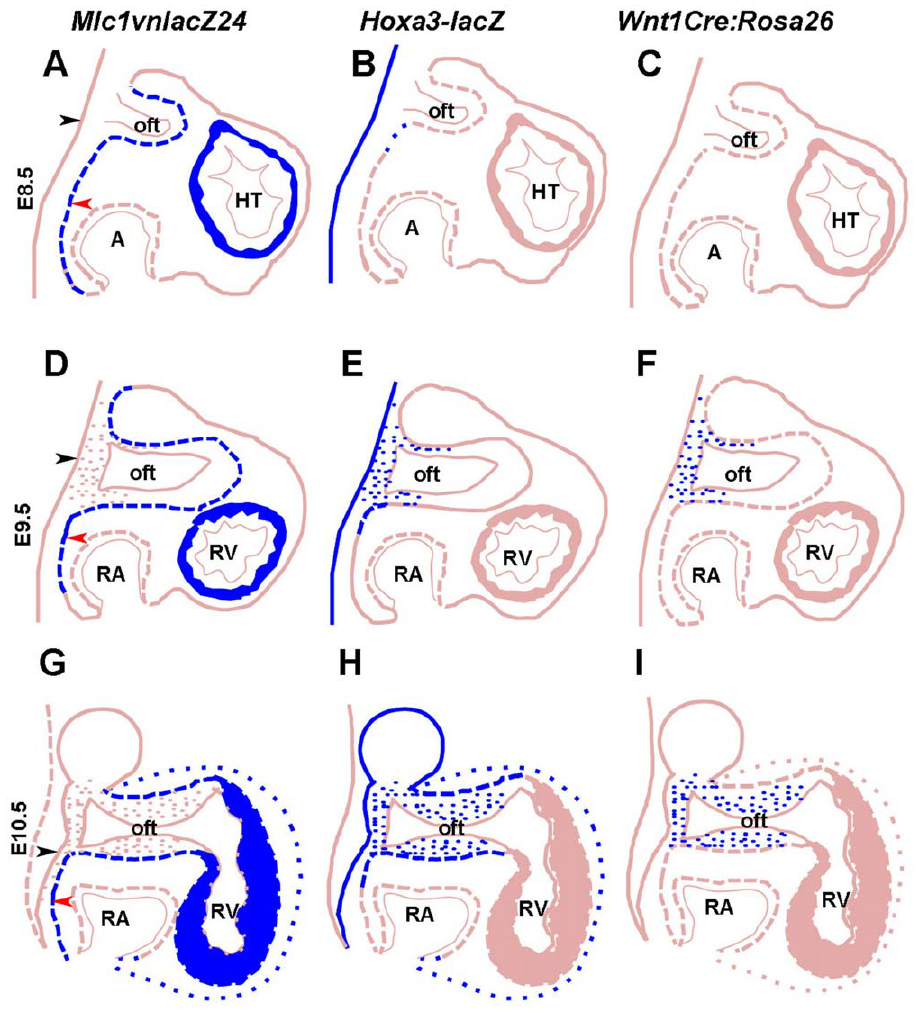
Figure 7. Schematic view of lacZ expression pattern in of Mlc1v-nlacZ24,Hoxa3-lacZ and Wnt1Cre:R26R cardiosensor lines. Mlc1v- nlacZ24 (A, D, G), Hoxa3-lacZ (B, E, H) and Wnt1 Cre:R26R (C, F, I). At E8.5 Mlc1v-nlacZ-24 are activated in the second heart field, developing OFT and heart tube (A), while Hoxa3-lacZ is activated in PE and barely detected in the SHF (B). At this stage the heart is devoid of migrating cardiac neural crest cells (C). At E9.5 the SHF progenitors, OFT and RV myocardium are labeled in Mlc1v-nlacZ-24 (D). The PE, CNC (dots in the caudal pharynx) and a subdomain of the SHF express Hoxa3-lacZ (E). Cardiac neural crest cells are also labeled in Wnt1cre;R26R bigenic embryos at E9.5 (F). At E10.5, Mlc1v- nlacZ-24 transgenic hearts identify SHF, OFT and RV (G). In addition to the anterior portion of SHF and PE, Hoxa3-lacZ transgene activity identifies cardiac neural crest and myocardial cells of the OFT, whereas the RV remains negative for lacZ staining (E). Cardiac neural crest cells similarly invades the OFT in Wnt1cre;R26R bigenic embryos at E10.5 (I). Hoxa3-lacZ clearly appears as an intermediary reporter line that display hybrid expression pattern reminiscent to that of Mlc1v-nlacZ24 and Wnt1cre;R26R bigenic. Blue and pink colors indicate lacZ -positive and -negative cells, respectively. Black and red arrowheads designate the pharyngeal endoderm (PE) and second heart field (SHF), respectively. A, atria; HT, heart tube; Oft, outflow tract; RA, right atria; RV, rigth ventricle.